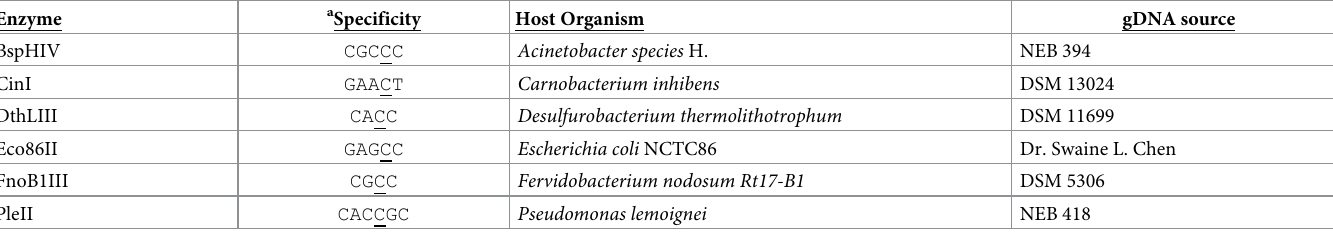
Table 1. Characterized m4C Type III R-M